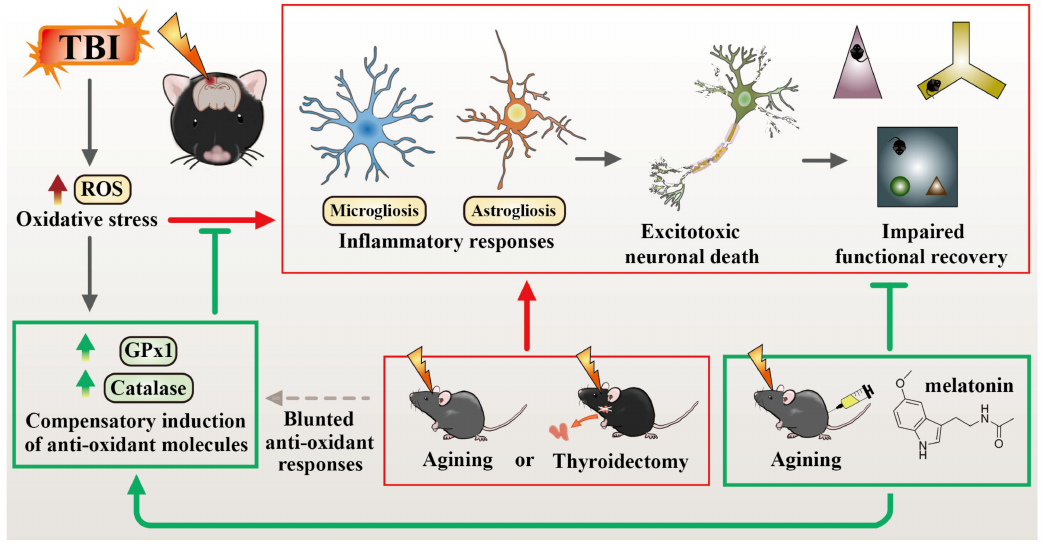
Figure 11. Working model of the major findings in our current study. Numerous pathological events initiated at the acute stage after brain trauma, which contribute to the profound behavioral deficits. Then, the induction of endogenous thyroid hormone-dependent compensatory regulation of anti-oxidant events ameliorates the oxidative stress and inflammatory events that lead to a gradual functional recovery of behavioral performance. Loss of such protective events after surgical